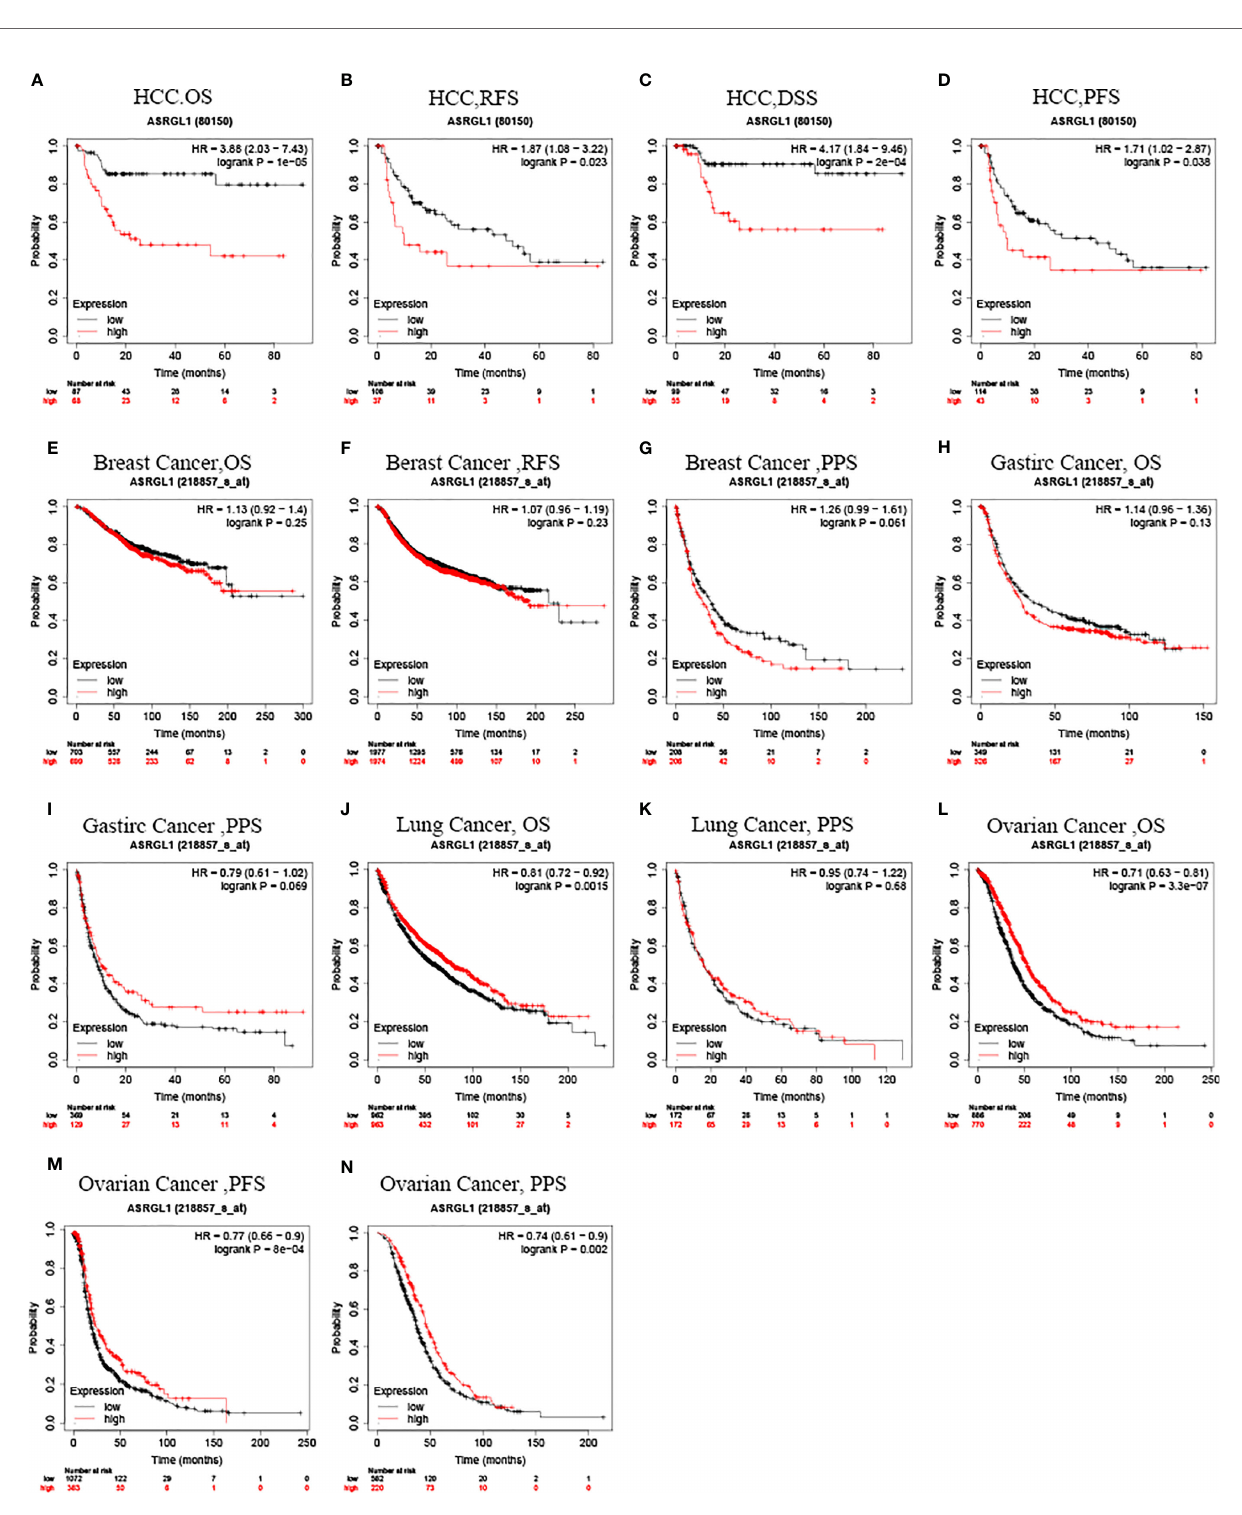
FIGURE 3 | Kaplan – Meier survival curve analysis of the prognostic signi fi cance of ASRGL1 expression based on the Kaplan – Meier plotter database. (A – D) Asian patients with higher ASRGL1 expression showed better OS, RFS, PFS, and DSS in HCC cohorts (n = 155, n = 145, n = 157, and n = 154, respectively). (E – G) Survival curves of OS, RFS, and PPS in the breast cancer cohort (n = 1404, n = 3951, and n = 414, respectively). (H, I) OS and DFS survival curves of gastric cancer (n = 875, n = 498). (J, K) Survival curves of OS and PPS in the lung cancer cohort (n = 344). (L – N) The OS, PFS, and PPS survival curves of ovarian cancer (n = 1,656, n = 1,435, and n = 782,